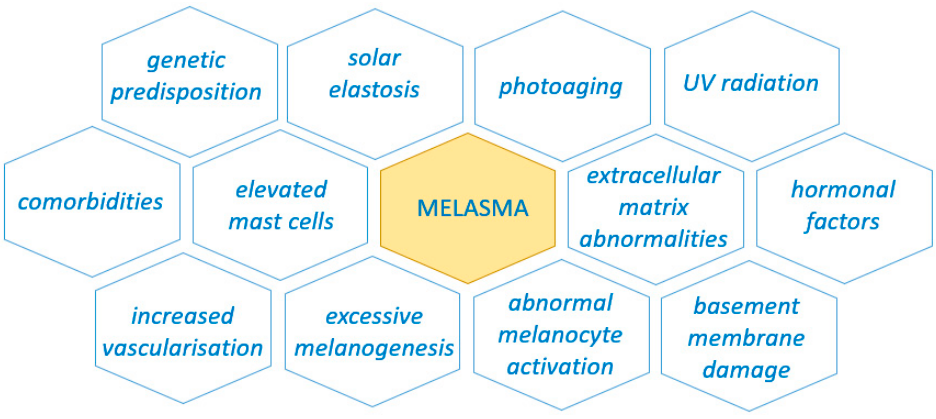
Figure 1. Factors contributing to the development of melasma.